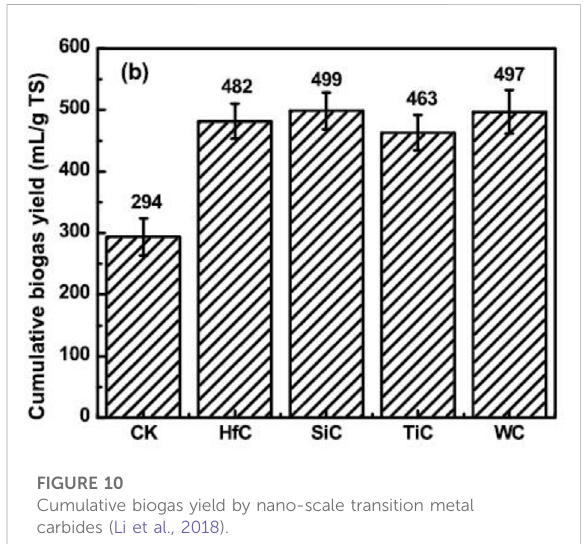
FIGURE 10 Cumulative biogas yield by nano-scale transition metal carbides (Li et al.,